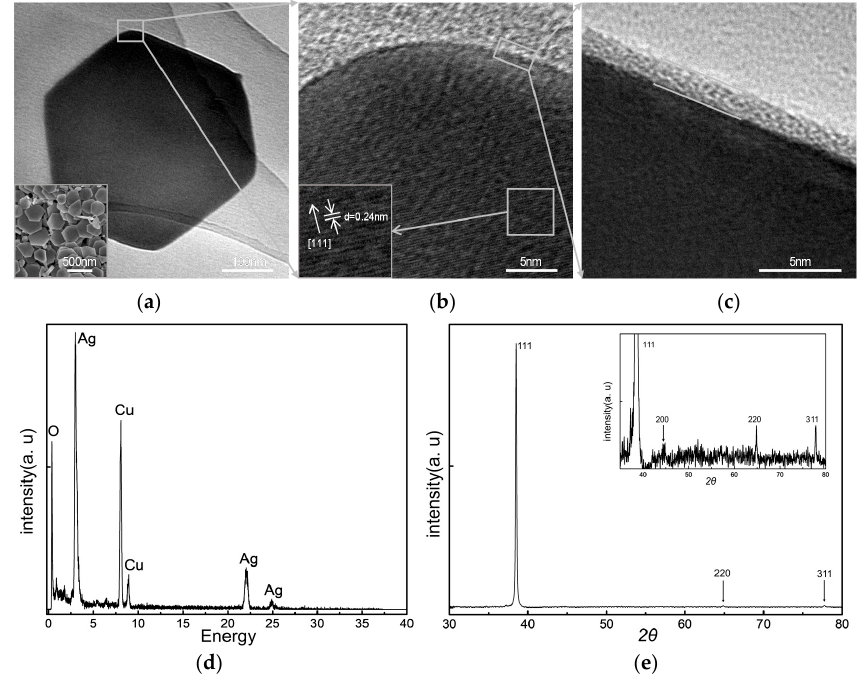
Figure 1. ( a ) The transmission electron microscopy image of silver nanoplate synthesized at 0 °C, with some tailed nanoplates shown in the insert of scanning electron microscope (SEM) image. ( b ) The high-resolution transmission electron microscopy (HRTEM) images show the lattice fringes and spacing of the silver nanoplate surface. ( c ) The HRTEM image shows the amorphous epitaxial layer on the edge of silver nanoplate. ( d ) The energy-dispersive spectrum of silver nanoplates (SNPs). ( e ) The X-ray di ff raction spectrum of SNPs with four peaks, which correspond to the face-centered cube (fcc) silver crystal structures.